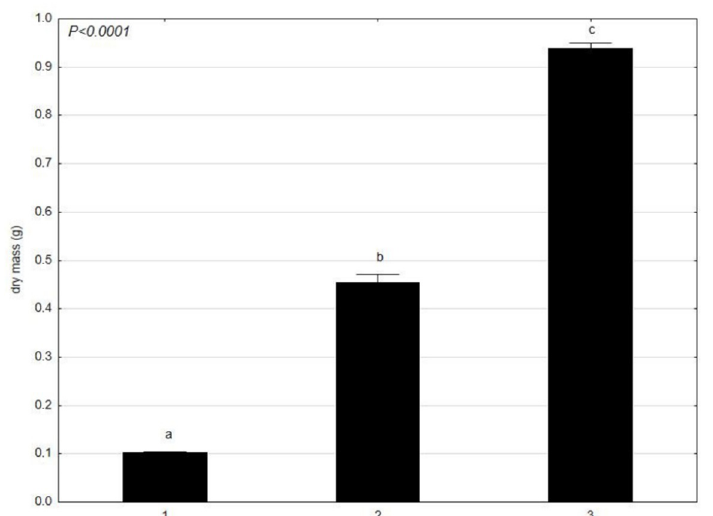
Molecules 2022 , 27 , x FOR PEER REVIEW 12 of 17 Figure 5. Mean value of dry mass (g) of C. glomerata at different times (1–30 April 2021; 2–4 June 2021; 3–17 July 2021) presented using the Tukey multiple comparisons test. The bars indicate mean values. Error bars represent standard error. A, B, C determines the statistical significance between the analyzed features. A statistically significant result for p ≤ 0.05 was marked.